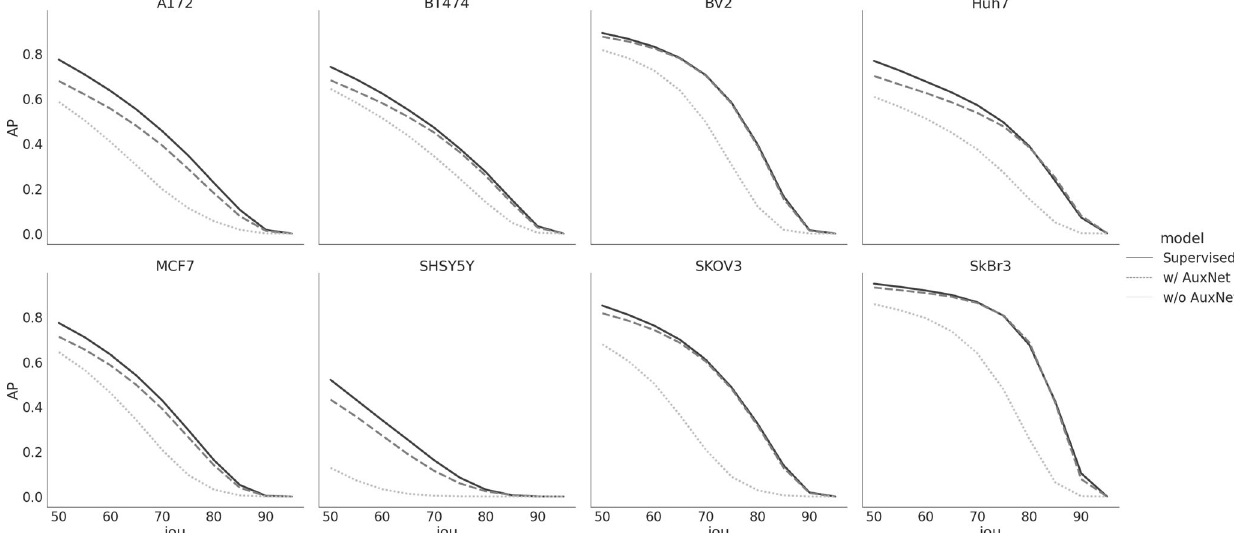
Fig. 4 LACSS model accuracy trained with LIVECell dataset. Models were trained either under full-supervision using the original single-cell annotation (supervised, solid line), under semi-supervision using synthetic annotation but without auxnet (dotted line), or under semi-supervision with boundary- de fi ning auxnet (dash line). AP values were computed for eight cell lines at increasing IOU thresholds from 50% to 95%. The results showed signi fi cant improvements in model accuracy by introducing auxnet in the training for models trained with